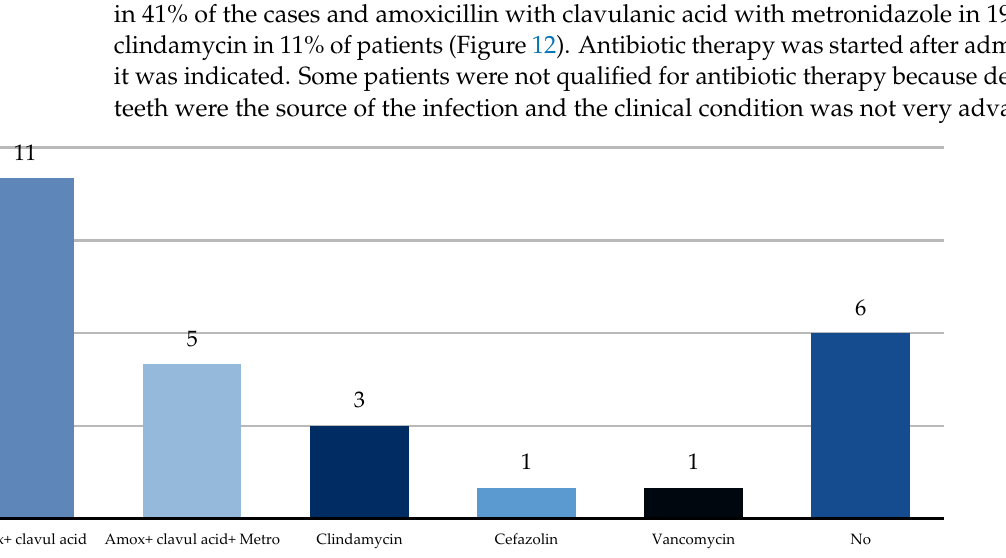
Figure 12. Antibiotics used for treatment.